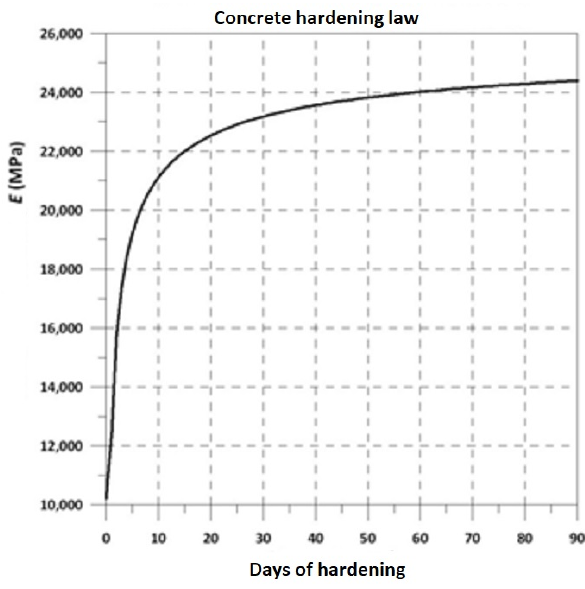
Figure 7. Shotcrete hardening curve [12].